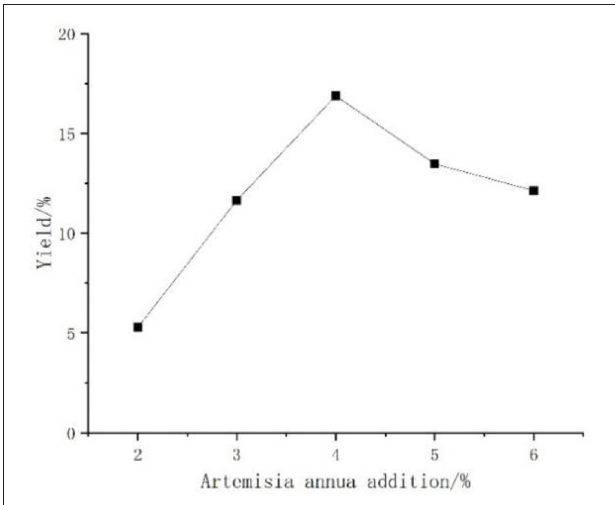
FIGURE 5 | Effect of Artemisia annua addition on the yield of Artemisia polysaccharides.